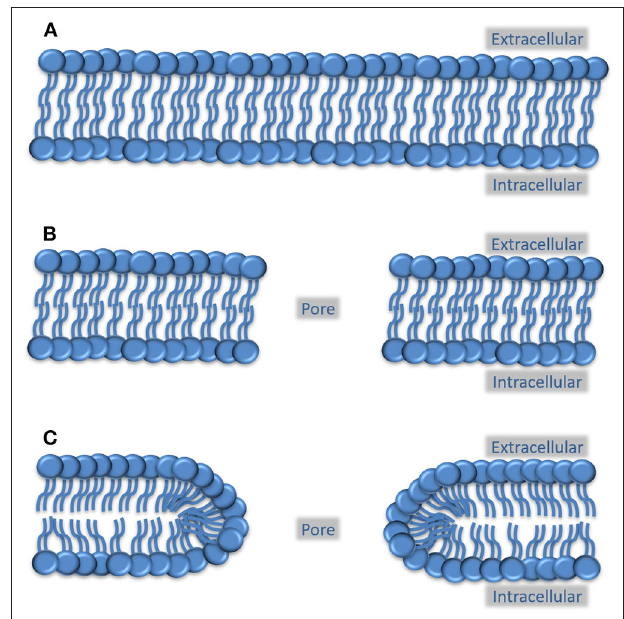
FIGURE 2 | Possible arrangement of phospholipids in a pore created by mechanoporation. (A) Preinjury cell membrane, where the circles indicate the hydrophilic phospholipid head groups and the lines indicate the hydrophobic phospholipid tails. (B) Phospholipid configuration in a hydrophobic membrane pore, where the hydrophobic tails face the edge of the pore. This type of pore is thought to be highly unstable and close in a fraction of a second. (C) Phospholipid configuration in a hydrophilic pore. Here, the polar head groups face the edge of the pore which prevents the pore from immediately collapsing. The crowding of the fatty acid tails at the edges does, however, causes instability and will, within minutes, lead to the closure of the